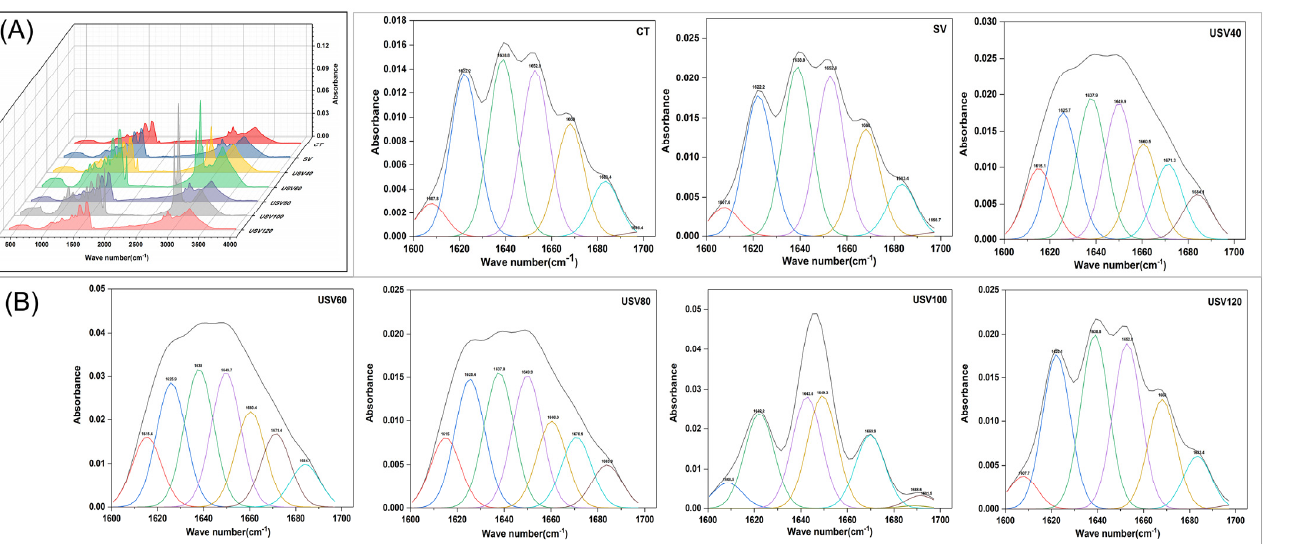
Table 3. Changes in relative protein secondary structure content of spiced beef under different ther- mal treatments.